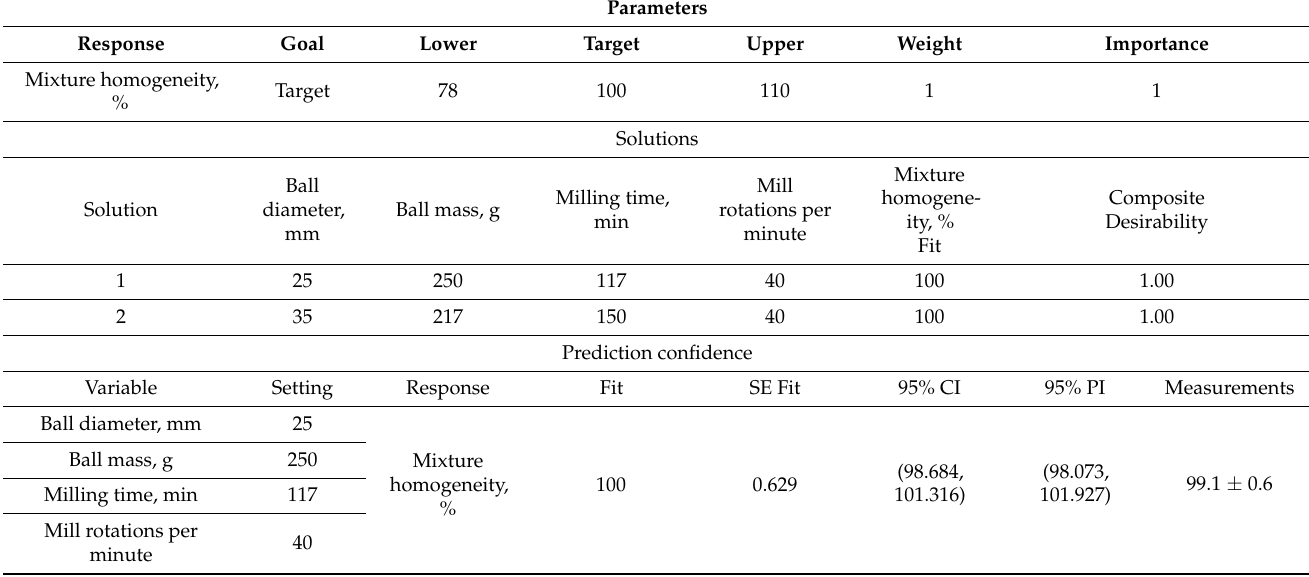
Table 2. Response optimization for the W + C mixture homogenization based on the developed regression model. SE—standard error, CI—confidence interval, PI—prediction